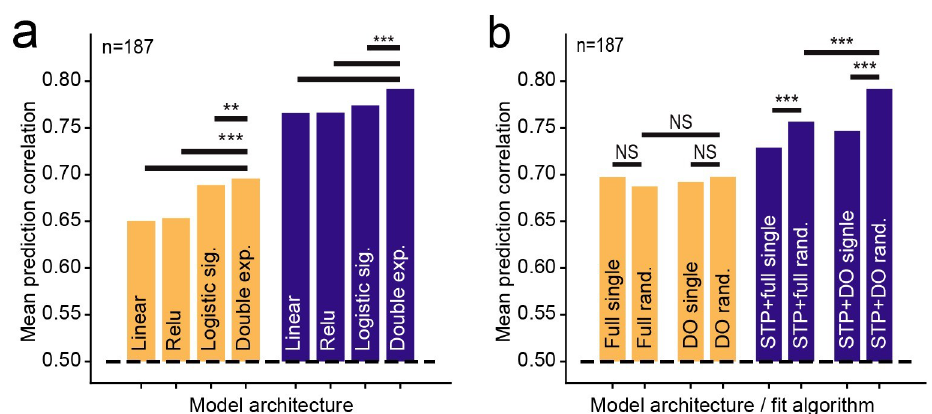
Fig 10. A. Impact of model output nonlinearity on prediction accuracy. Groups of bars compares mean prediction accuracy of LN (orange) and local STP models (blue) with different output nonlinearities using the vocalization- modulated noise data. In both the LN and STP architectures, the double exponential sigmoid shows better performance than a model with no output nonlinearity (linear), linear rectification (relu), and a logistic sigmoid ( ��� p < 10 − 5 ; NS: p > 0.05 sign test). B. Comparison of initialization method and parameterization on LN (orange) and local STP model (blue) performance. Full models used non-parameterized temporal filter functions, and DO indicates model in which the temporal filter is constrained to be a damped oscillator. Single fits started from a single initial condition, and random fits stated a 10 different initial conditions, selecting the best-performing model on the estimation data. Initialization and parameterization had little impact on LN model performance, but both random initialization and DO parameterization improved performance for the local STP model ( �� p < 10 − 4 ; ��� p < 10 − 5 ; NS: p > 0.05 sign